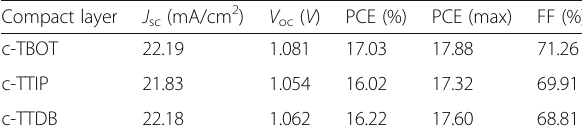
Table 1 Photovoltaic parameters of the cells with different compact layers